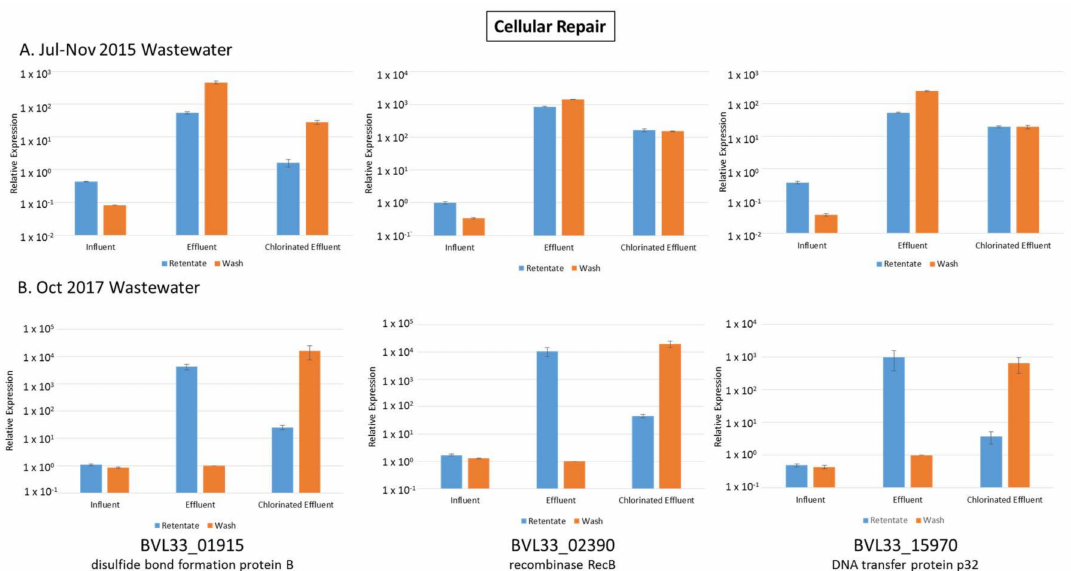
Figure 2. Relative expression profiles of A. junii genes involved in cellular repair. These genes displayed >2-fold change on RNA-seq analysis of wastewater sampled in July–November 2015 (Table 1). Gene expression values were normalized against a housekeeping rpoB gene. ( A ) Wastewater sampled in July, October and November of 2015; and ( B ) wastewater sampled in October 2017